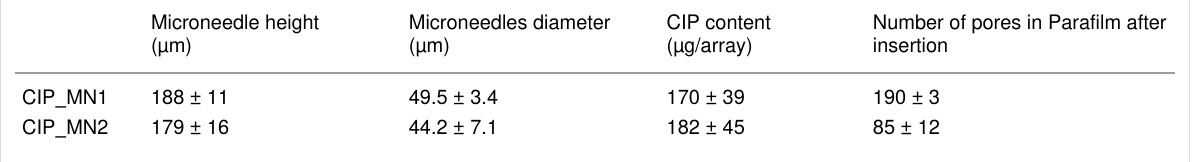
Table 1: Physical characteristics of CIP_MN1 and CIP_MN2, that is, height, diameter, CIP content, and number of pores in Parafilm after insertion, n =